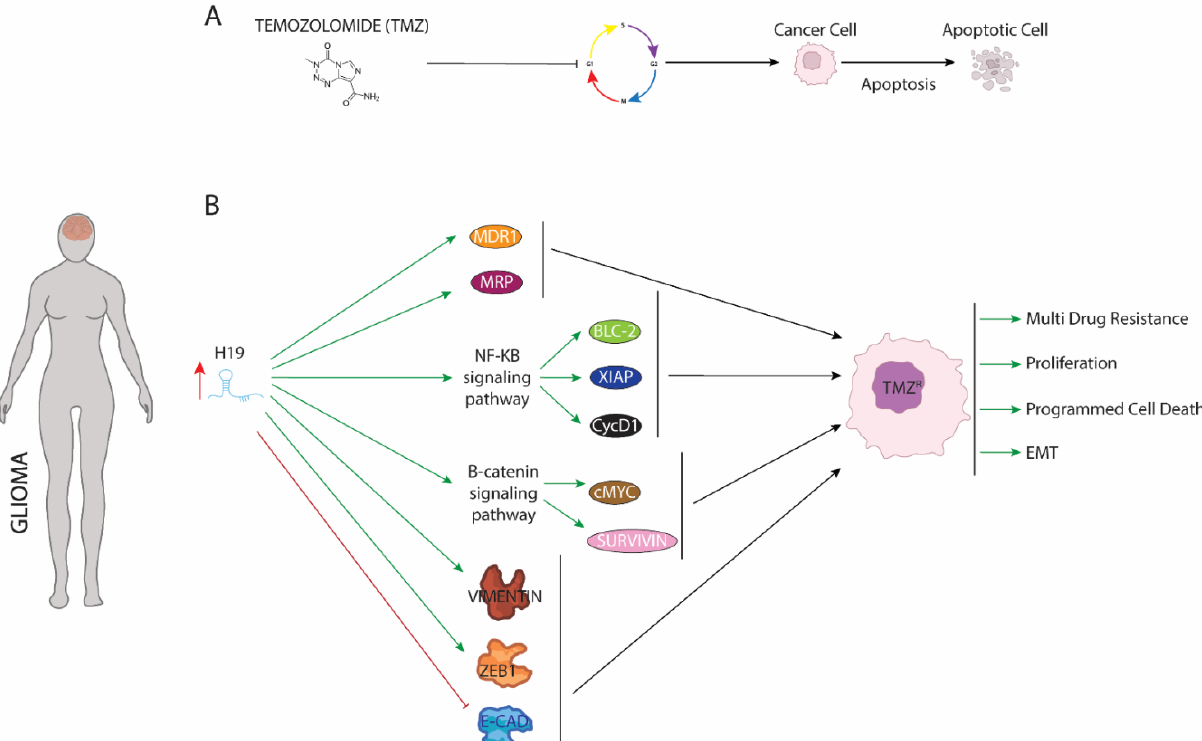
Figure 3. Schematic representation of molecular mechanism dependent of H19 function in glioma. ( A ) Mode of action of temozolomide. ( B ) Upregulation of H19 increase expression of proteins involved in multidrug resistance, apoptosis, and EMT procedures enhancing proliferation, programmed cell death, and EMT.